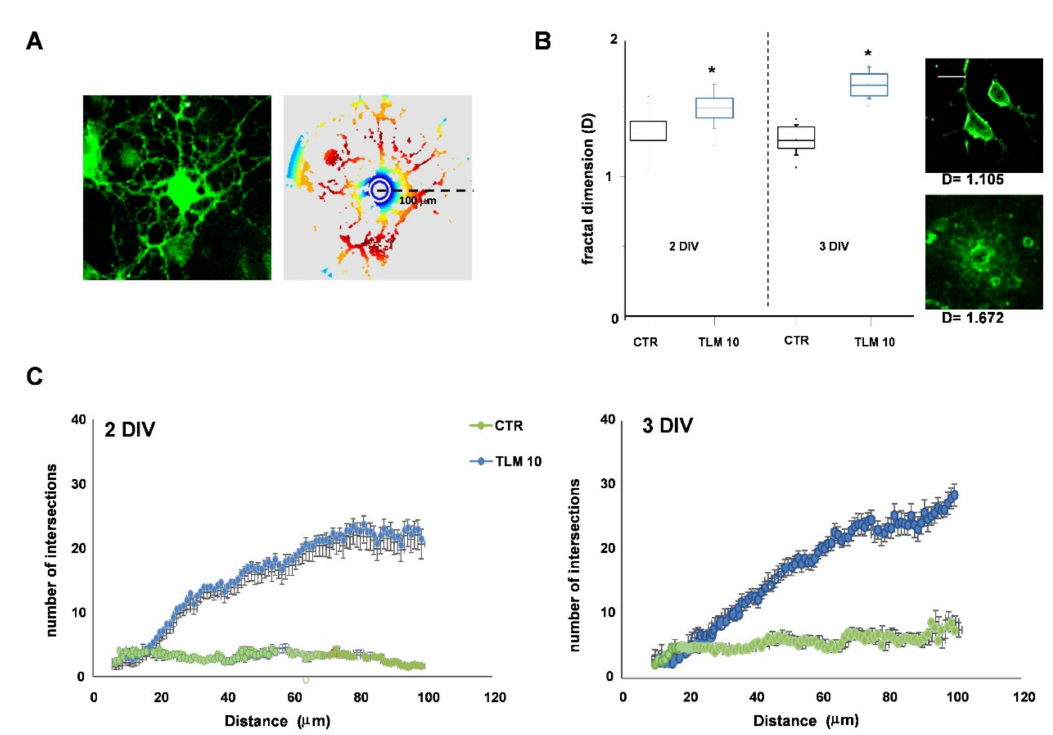
Figure 4. TLM increases the morphological complexity of OPs. Panel ( A ) shows a representative image of a single OP labelled with O 4 and its corresponding schematic image reconstructed with ImageJ used for the Sholl analysis. At 1DIV, OPs were treated with 10 nM TLM for 24 or 48 h. The average number of intersections for each Sholl profile at 2–3DIV is shown in ( C ). Data represent Means + SEM ( n = 3 independent experiments on 550–600 OPs; p < 0.001). The D values (fractal dimension) are shown in ( B ). Values represent at least 3 independent preparations on 50 OPs (* p < 0.0001 vs. CTR, unpaired two-tailed Student t -test). Representative images of cells studied are shown near the box plot graph. Scale bar = 20 µ